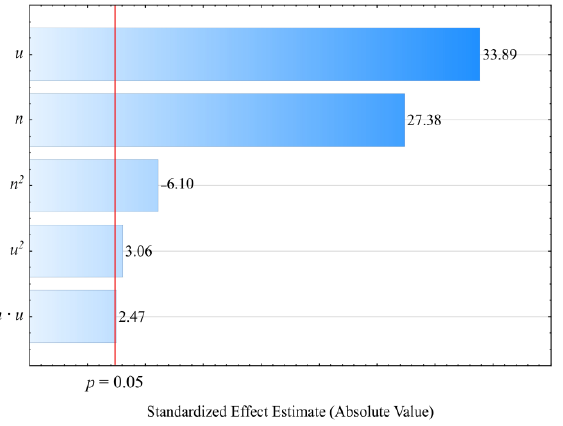
Figure 6. Pareto charts of the standardized effects for the empirical model P of the polymer blend pressure; the vertical line in the plot corresponds to the arbitrarily chosen level of significance ( p = 0.05).